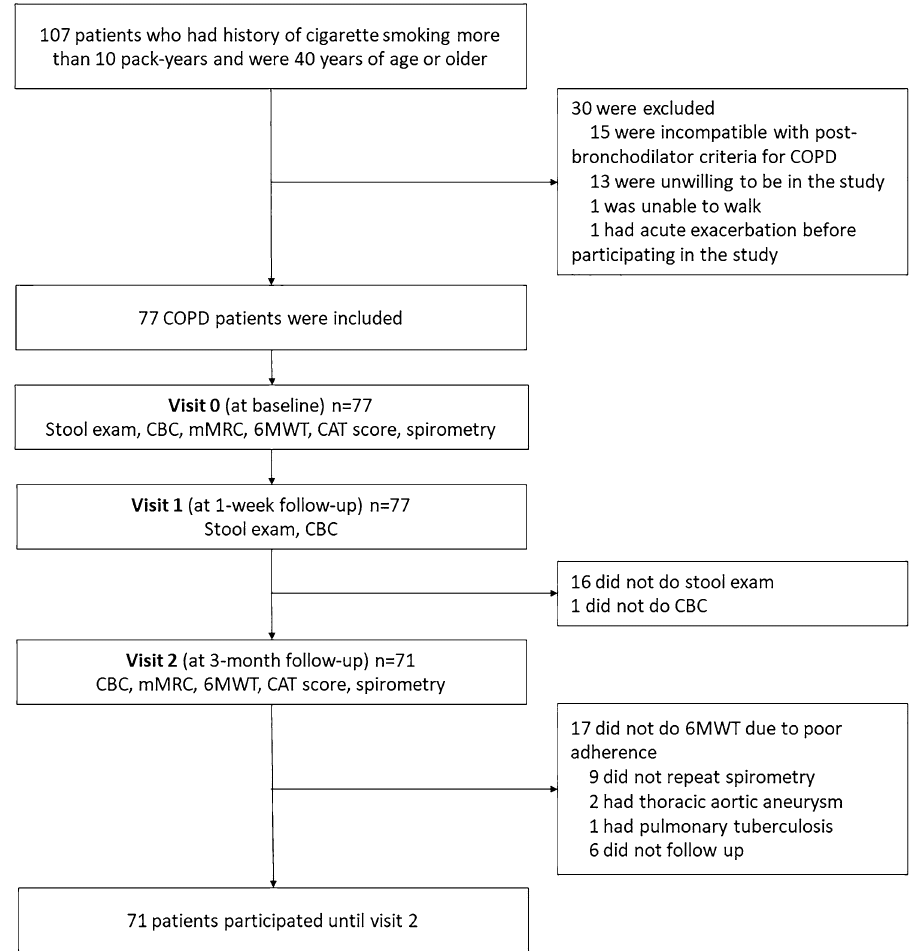
Figure 1. Flow chart of patient recruitment to the study. COPD Chronic obstructive pulmonary disease, mMRC modified Medical Research Council, CAT COPD Assessment Test, CBC complete blood count, 6MWT Six- minute walk